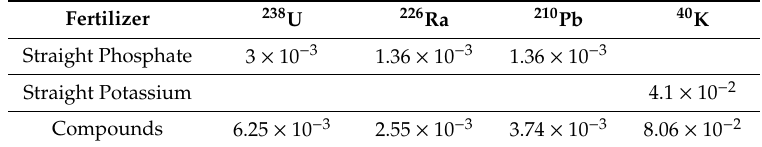
Table 4. Actual activity concentration of radionuclides in the soil in the region of Veneto (Bq / kg).